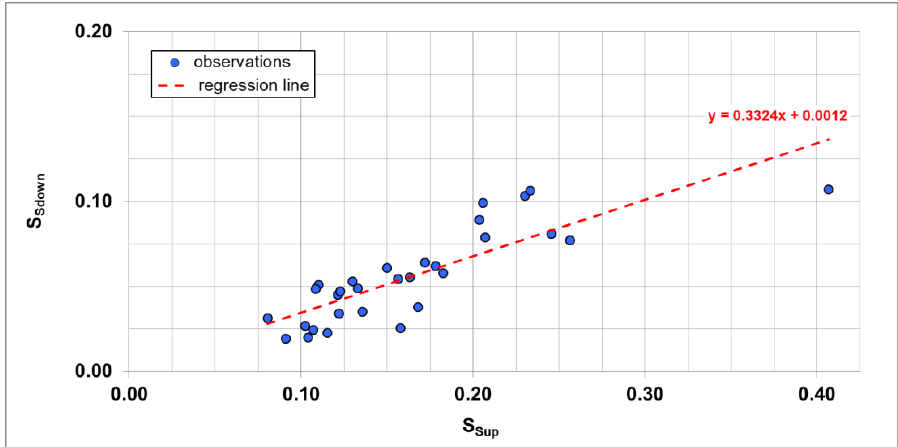
Figure 3. Upvalley stream slopes vs downvalley stream slopes of the selected catchments (see Table A1 in Appendix A for definition).